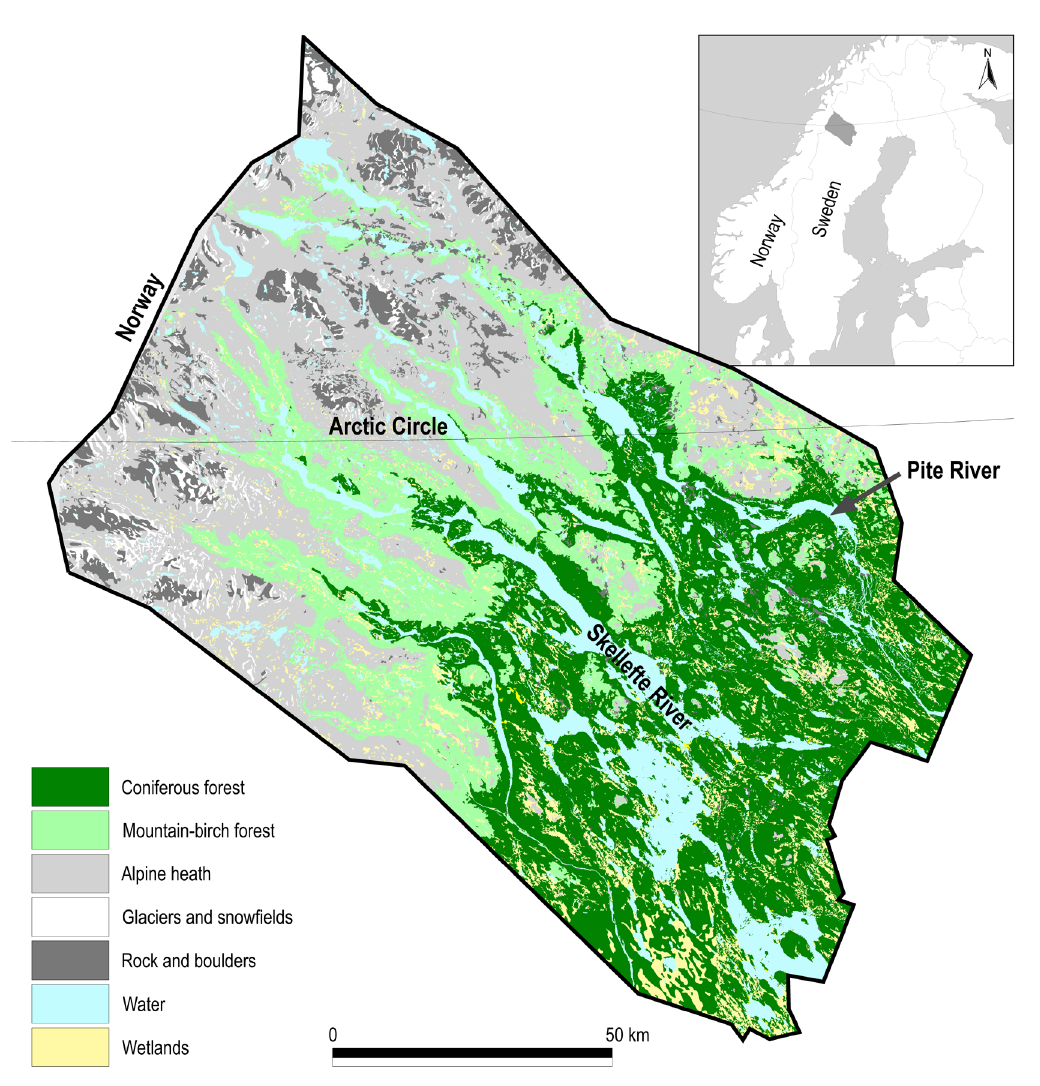
Figure 2. Main land cover in Arjeplog Municipality in northern Sweden. Our field study took place in the conif- erous forests of the Pite River valley. ©